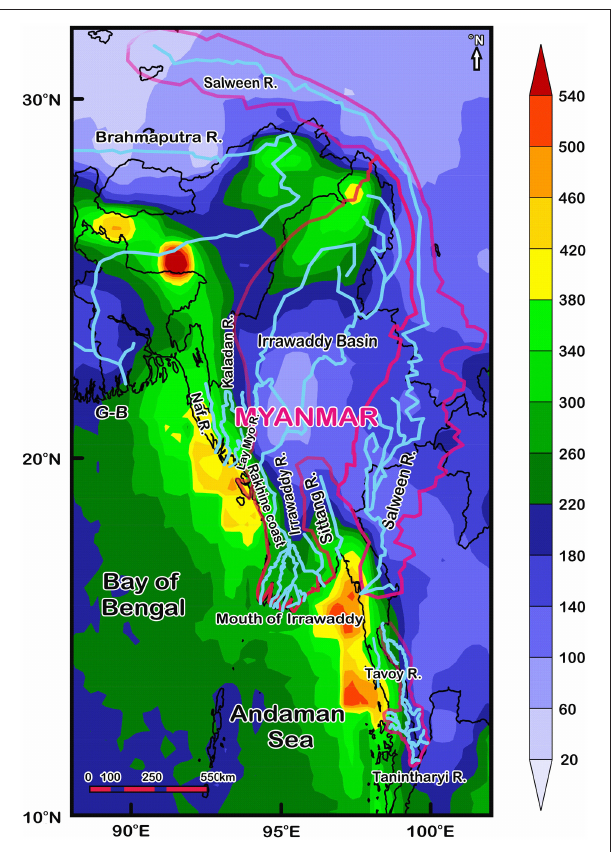
FIGURE 2 | The average rainfall (cm/y) pattern for the 5 years (January 1998 to December 2002) over the present study area. Please note the intensely focused precipitation ( ∼ 5 m/y) over the western slopes of the Indo–Burman–Arakan ranges along the Rakhine coast and over the western slope of Western/Central granitic ranges in Southern Myanmar (Source: http://trmm.gsfc.nasa.gov/).